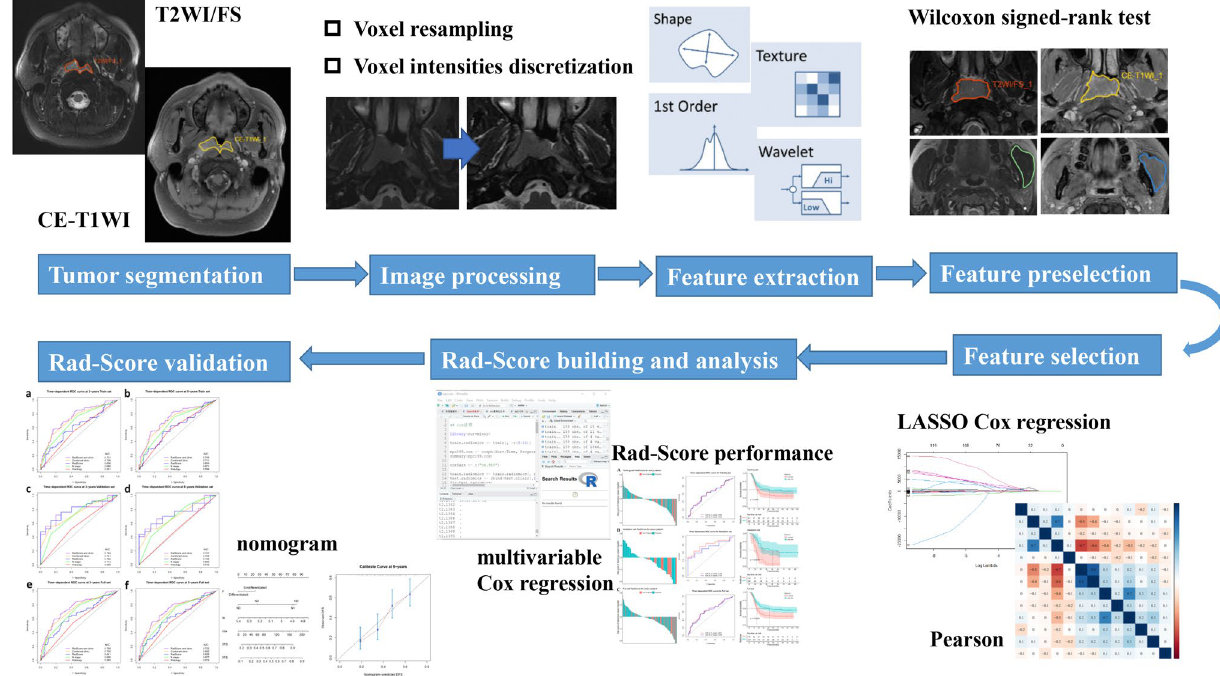
Fig. 2 Workflow of the radiomics